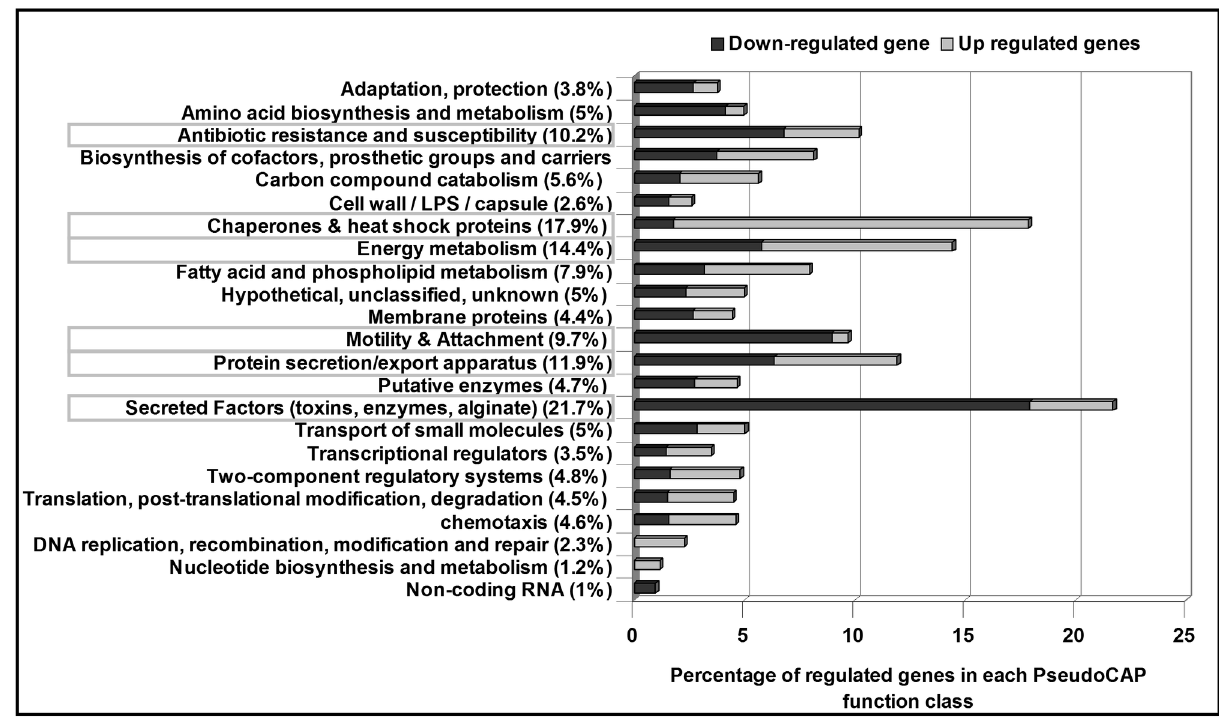
Figure 1. Functional classes of SigX-regulated genes identified by expression profiling on DNA array. All 307 genes that had a significant difference in expression between wildtype and mutant strains (Fold change ≥2, p -value ≤0.05 as determined by Empirical Bayes) were included and classified according to their function. Functional classes were determined using the Pseudomonas Genome Project website (www.pseudomonas.com; Winsor et al., 2011), among which these framed in grey were